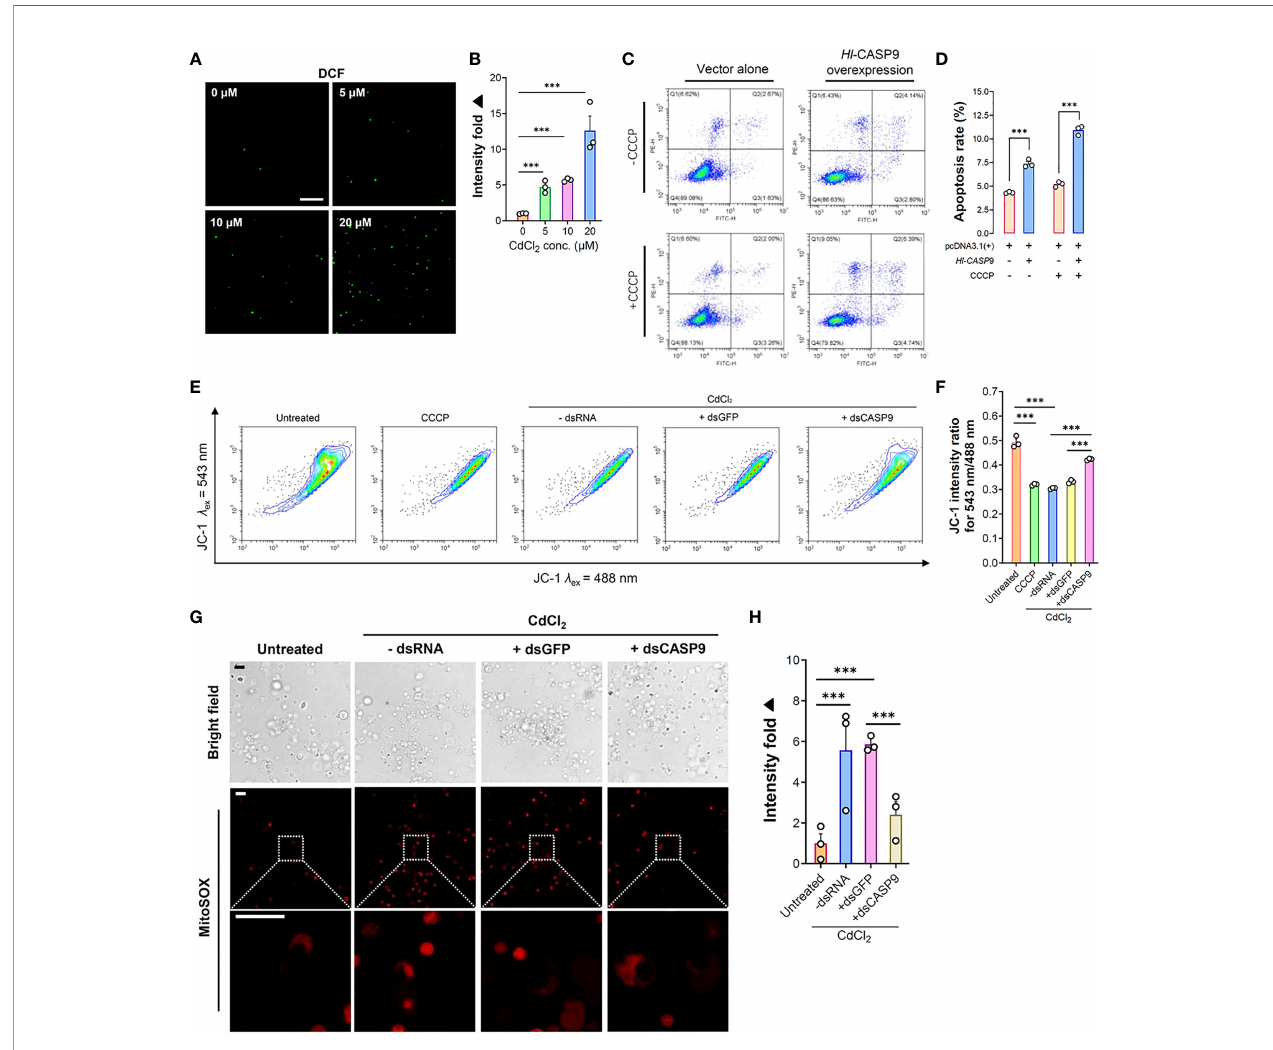
FIGURE 5 | Formation of cellular ROS and associated mitochondrial stress in CdCl 2 -treated coelomocytes. (A) In vitro dose-dependent effects of CdCl 2 (at 3 h) on ROS formation levels in primary coelomocytes as detected by the fl uorescent DCF. Scale bar: 50 m m. (B) Quanti fi cation of DCF fl uorescence intensities as reported in (A) . (C) Effects of Hl-CASP9 overexpression on apoptosis in HEK293T cells, as analyzed by fl ow cytometry. HEK293T cells were treated with or without CCCP (100 m M). Comparisons are made between group with vector alone (HEK293T cells transfected with pcDNA3.1(+) blank plasmid) and group overexpressing Hl- CASP9 (HEK293T cells transfected with pcDNA3.1(+)/ Hl-CASP9 recombinant plasmid). (D) Comparison on average apoptosis rates in HEK293T cells treated with or without CCCP in different groups. (E) Changes in mitochondrial membrane potential ( D y m) in CdCl 2 -treated primary coelomocytes with or without dsRNA (including dsGFP and dsCASP9) as assessed by JC-1 (2.5 m M) in fl ow cytometry. For comparison, coelomocytes were treated with or without CCCP (100 m M) or CdCl 2 (20 m M). (F) Changes of D y m in coelomocytes in response to CdCl fi ed by JC-1 intensity ratio for l m M) 2 were quanti ex 543 nm/488 nm. (G) In vitro effects of CdCl 2 (20 on mitochondrial superoxide formation in primary coelomocytes with or without dsRNA (including dsGFP and dsCASP9), as visualized by MitoSOX (2.5 m M) in confocal imaging. Scale bar: 15 m m. (H) Quanti fi cation of MitoSOX fl uorescence intensities in coelomocytes. Data were analyzed by using